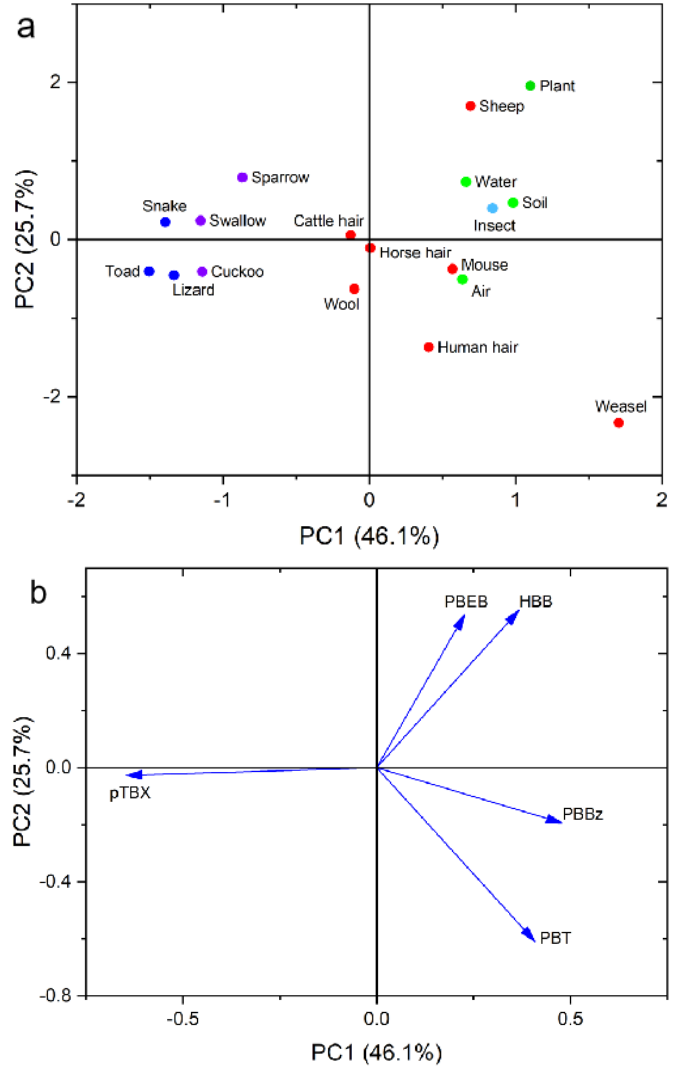
Figure 4. Two − dimensional principal component analysis: ( a ) score plot and ( b ) factor loading plot for the novel brominated flame retardant concentrations in the samples from grasslands in Inner Mongolia, China.